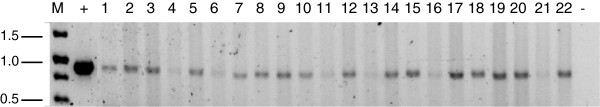
Screening of T. atroviride co-transformants for the presence of the nptII gene. Genomic DNA was isolated from 22 geneticin-resistant transformants resulting from co-transformation of T. atroviride P1 with plasmids pKAtga3 and pII99 and analyzed by PCR for integration of the nptII gene using primers pII99Fw and pII99Rev. M, DNA size standard; +, plasmid pII99; 1–22, transformants; -, wild-type.